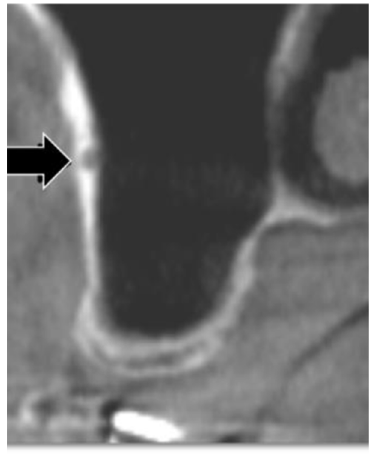
Fig. 1. Intraosseous variety of PSAA.